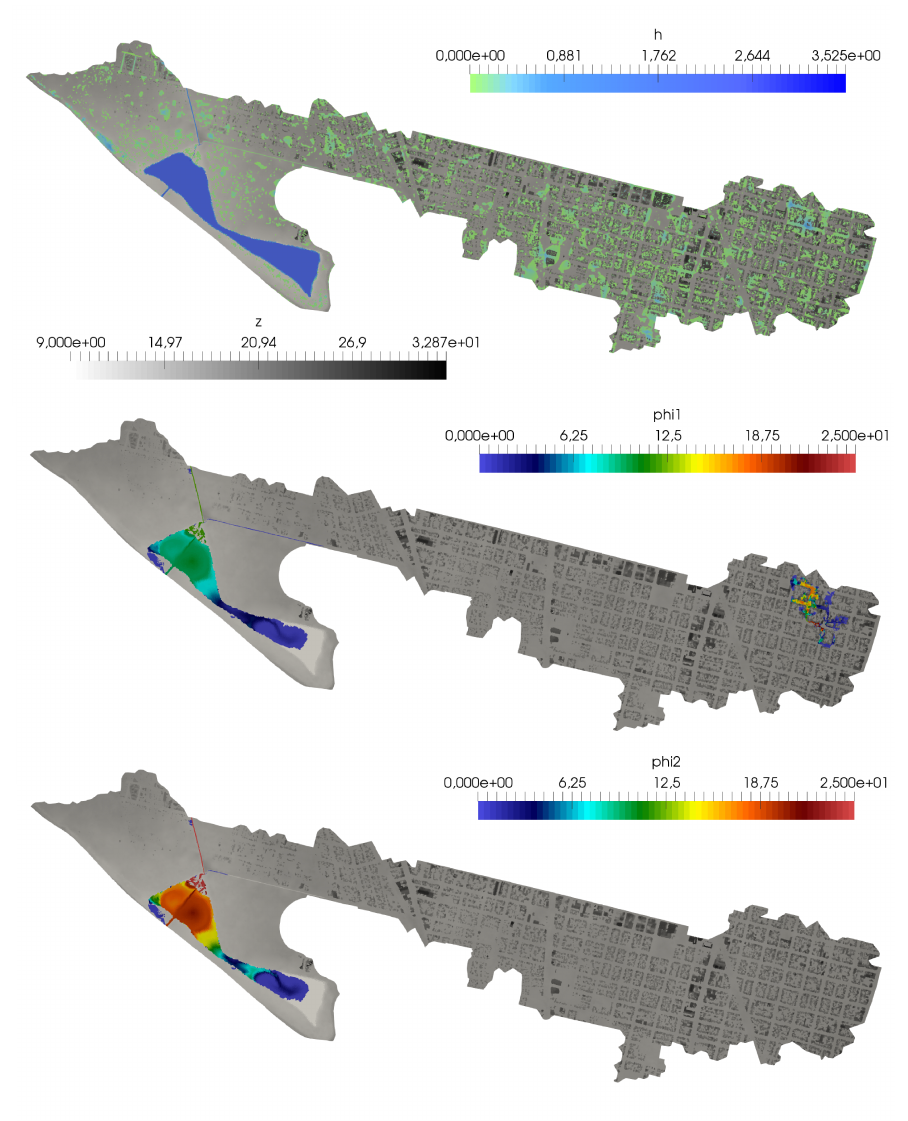
Figure 21. Case 3: Surface water depth h ( upper ) and pollutant concentration for both solutes φ 1 ( center ) and φ 2 ( lower ) at t = 12 h.